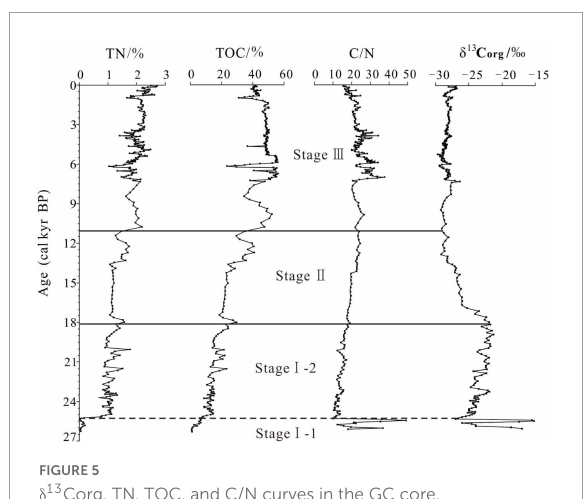
FIGURE5 δ 13 Corg, TN, TOC, and C/N curves in the GC